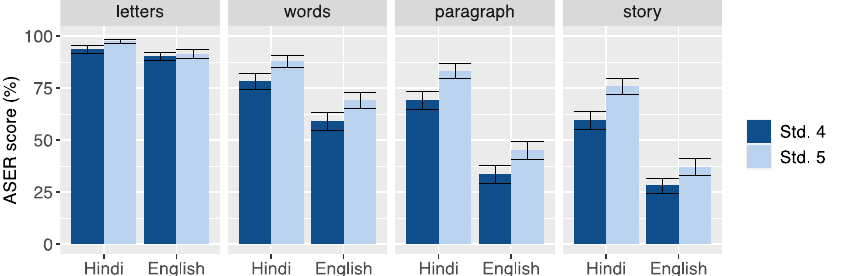
Figure 2. Children’s performance on the different components of the ASER literacy task at the two time points (Std. 4 and Std. 5) and in the two languages (Hindi and English) depicted as the means and 95% confidence intervals.